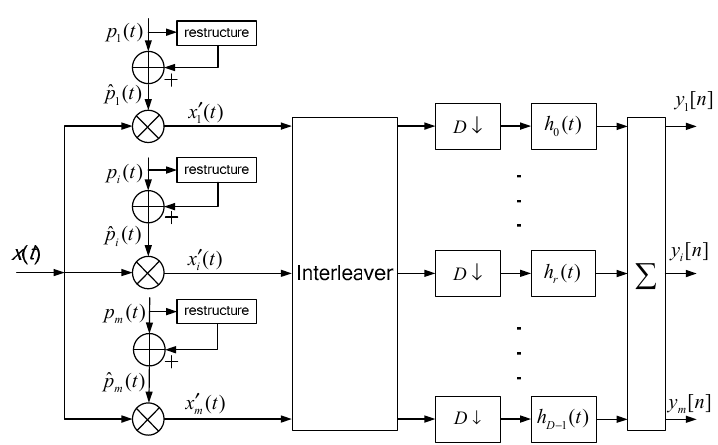
Figure 5. Improved channelized MWC under-sampling system.